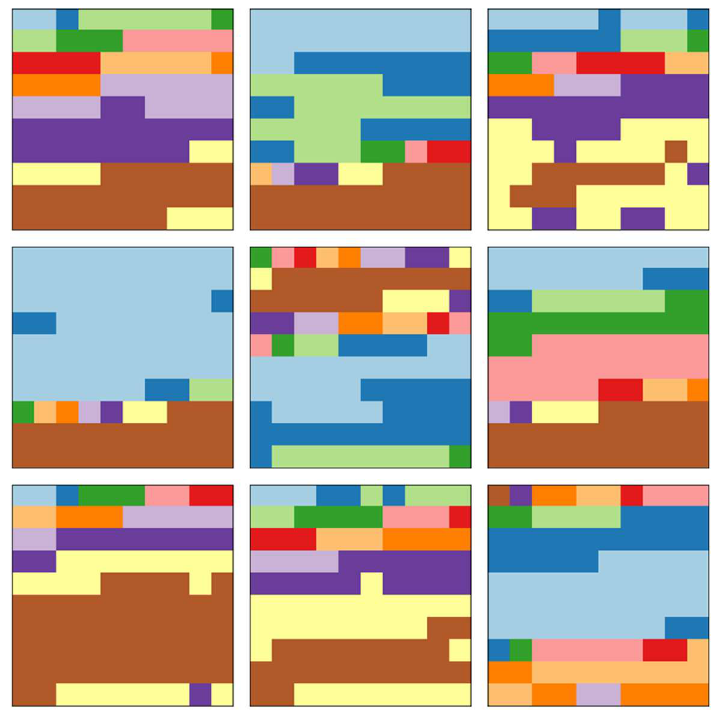
Figure 11. 2D spectral feature maps of 16 classes in the Pavia University dataset.